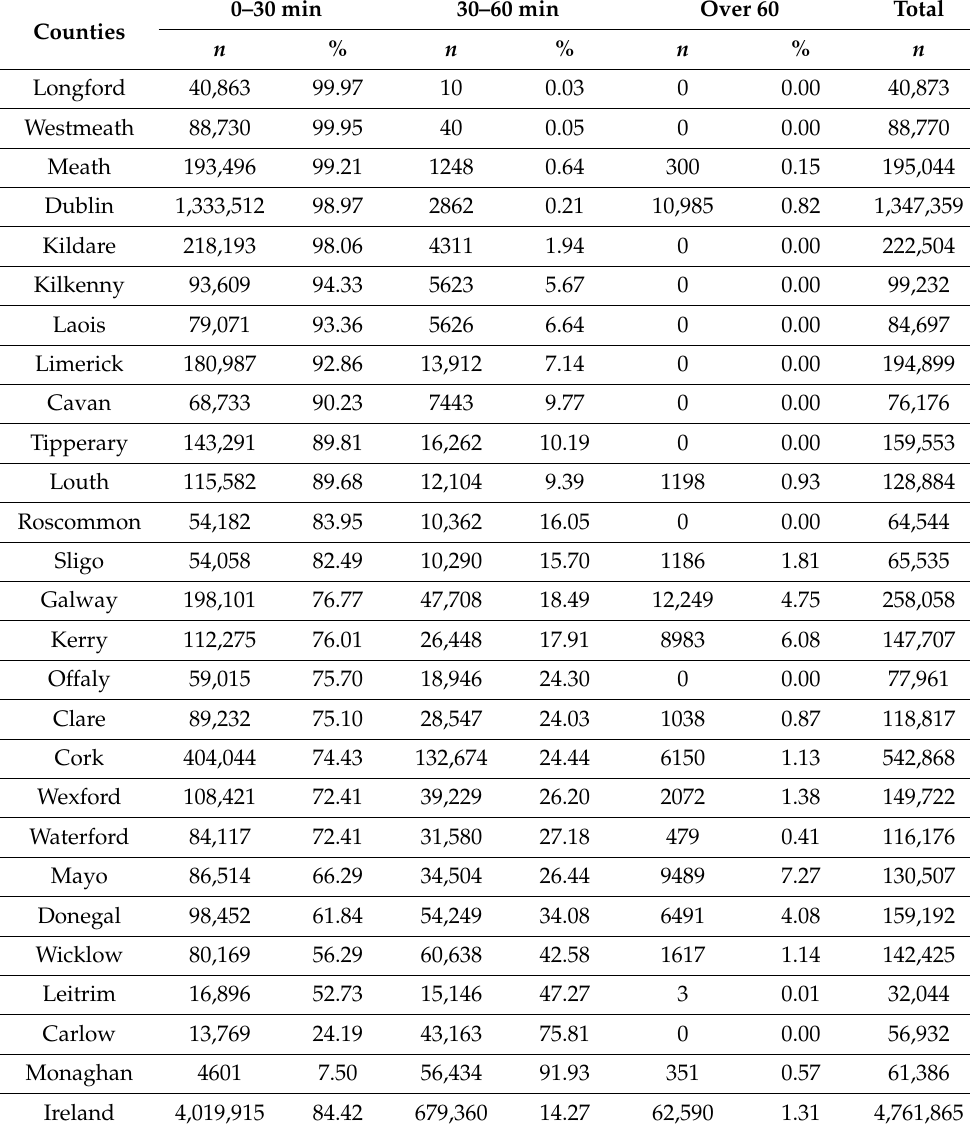
Table 2. Population living at different driving times from the specialized palliative care services across counties in